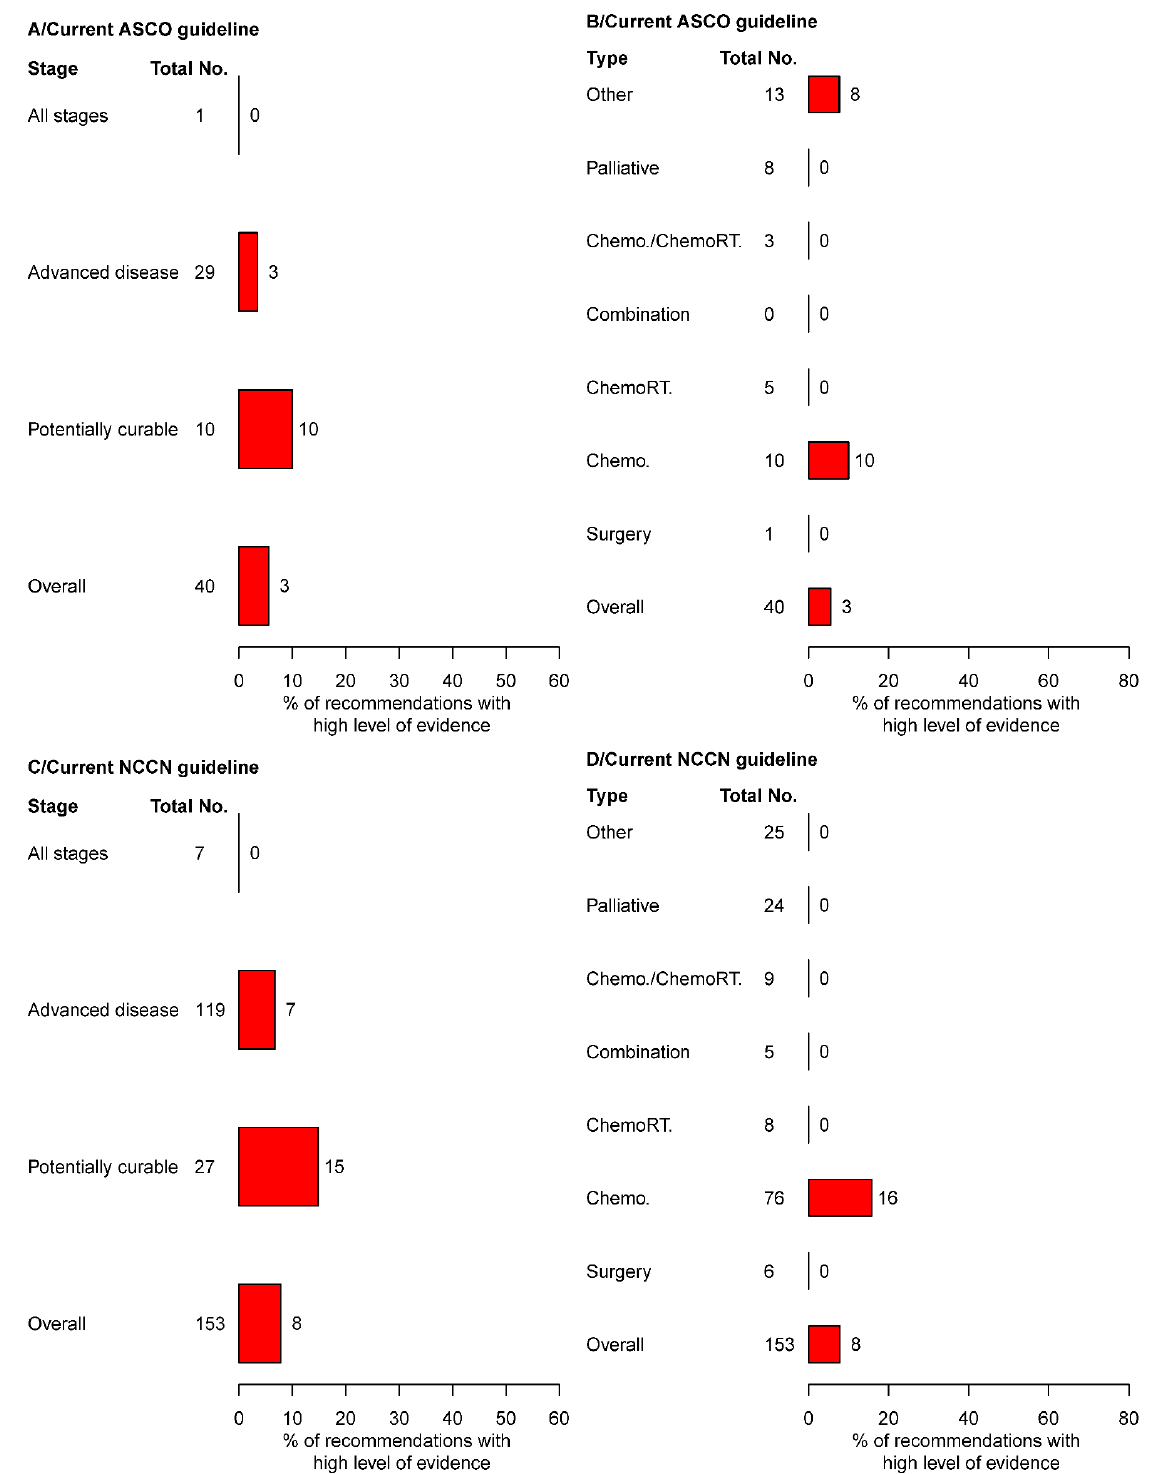
Figure 2. Proportion of therapeutic recommendations classified by high level of evidence in current ASCO and NCCN guidelines: overall, per disease stage and per treatment category: ( A , B ) results for the ASCO guidelines; ( C , D ) results for the NCCN guidelines. Total No. represents the number of treatment recommendations per disease category. No.: number, ASCO: American society of clinical oncology, NCCN: national comprehensive cancer